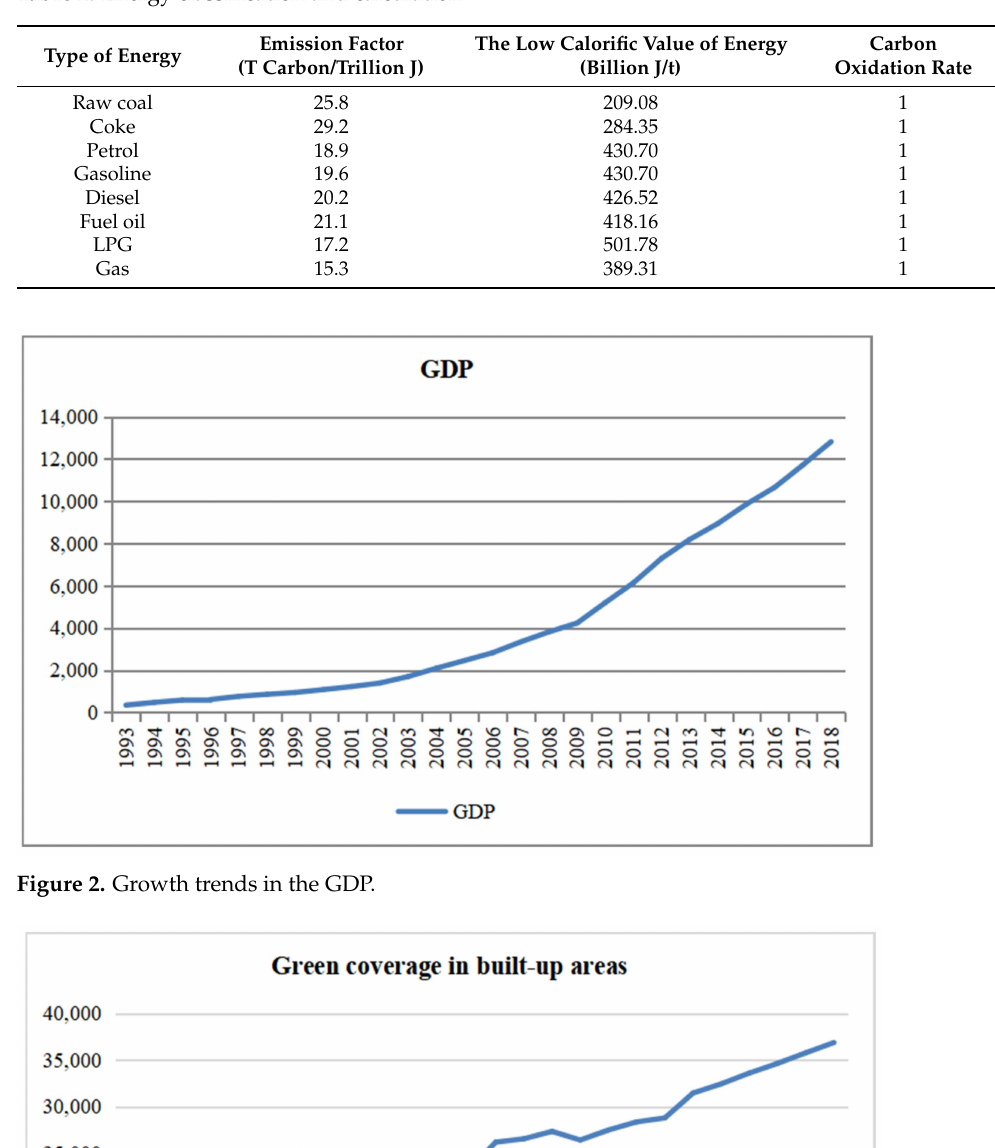
Table 2. Energy classification and calculation.